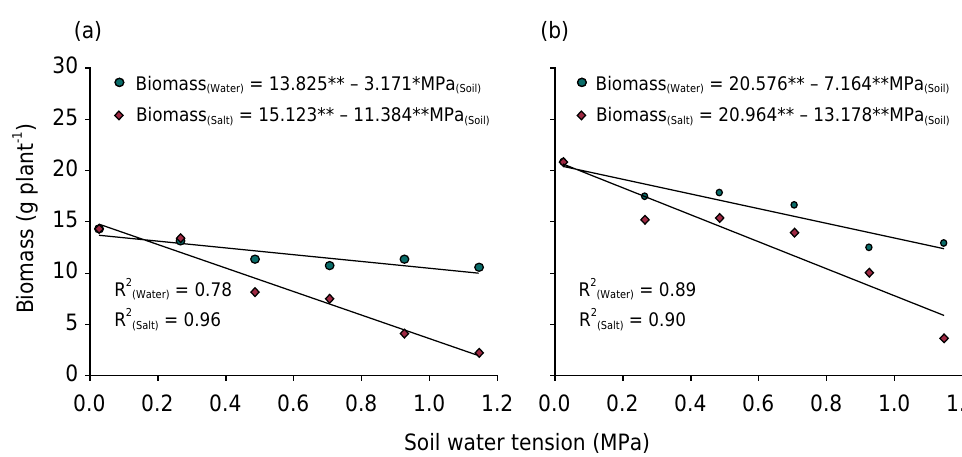
Figure 2. Shoot biomass yield (dry matter) of Vigna unguiculata plants (IPA-206 cultivar) evaluated 90 days after stress by treatments applied at the vegetative (a) and flowering (b) stages, respectively.